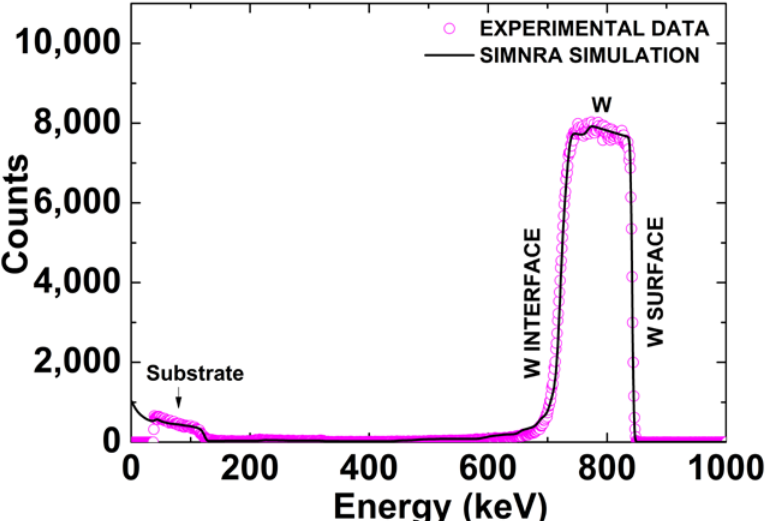
Figure 5. Experimental RBS data represented against the simulated spectrum in SIMNRA for W50.